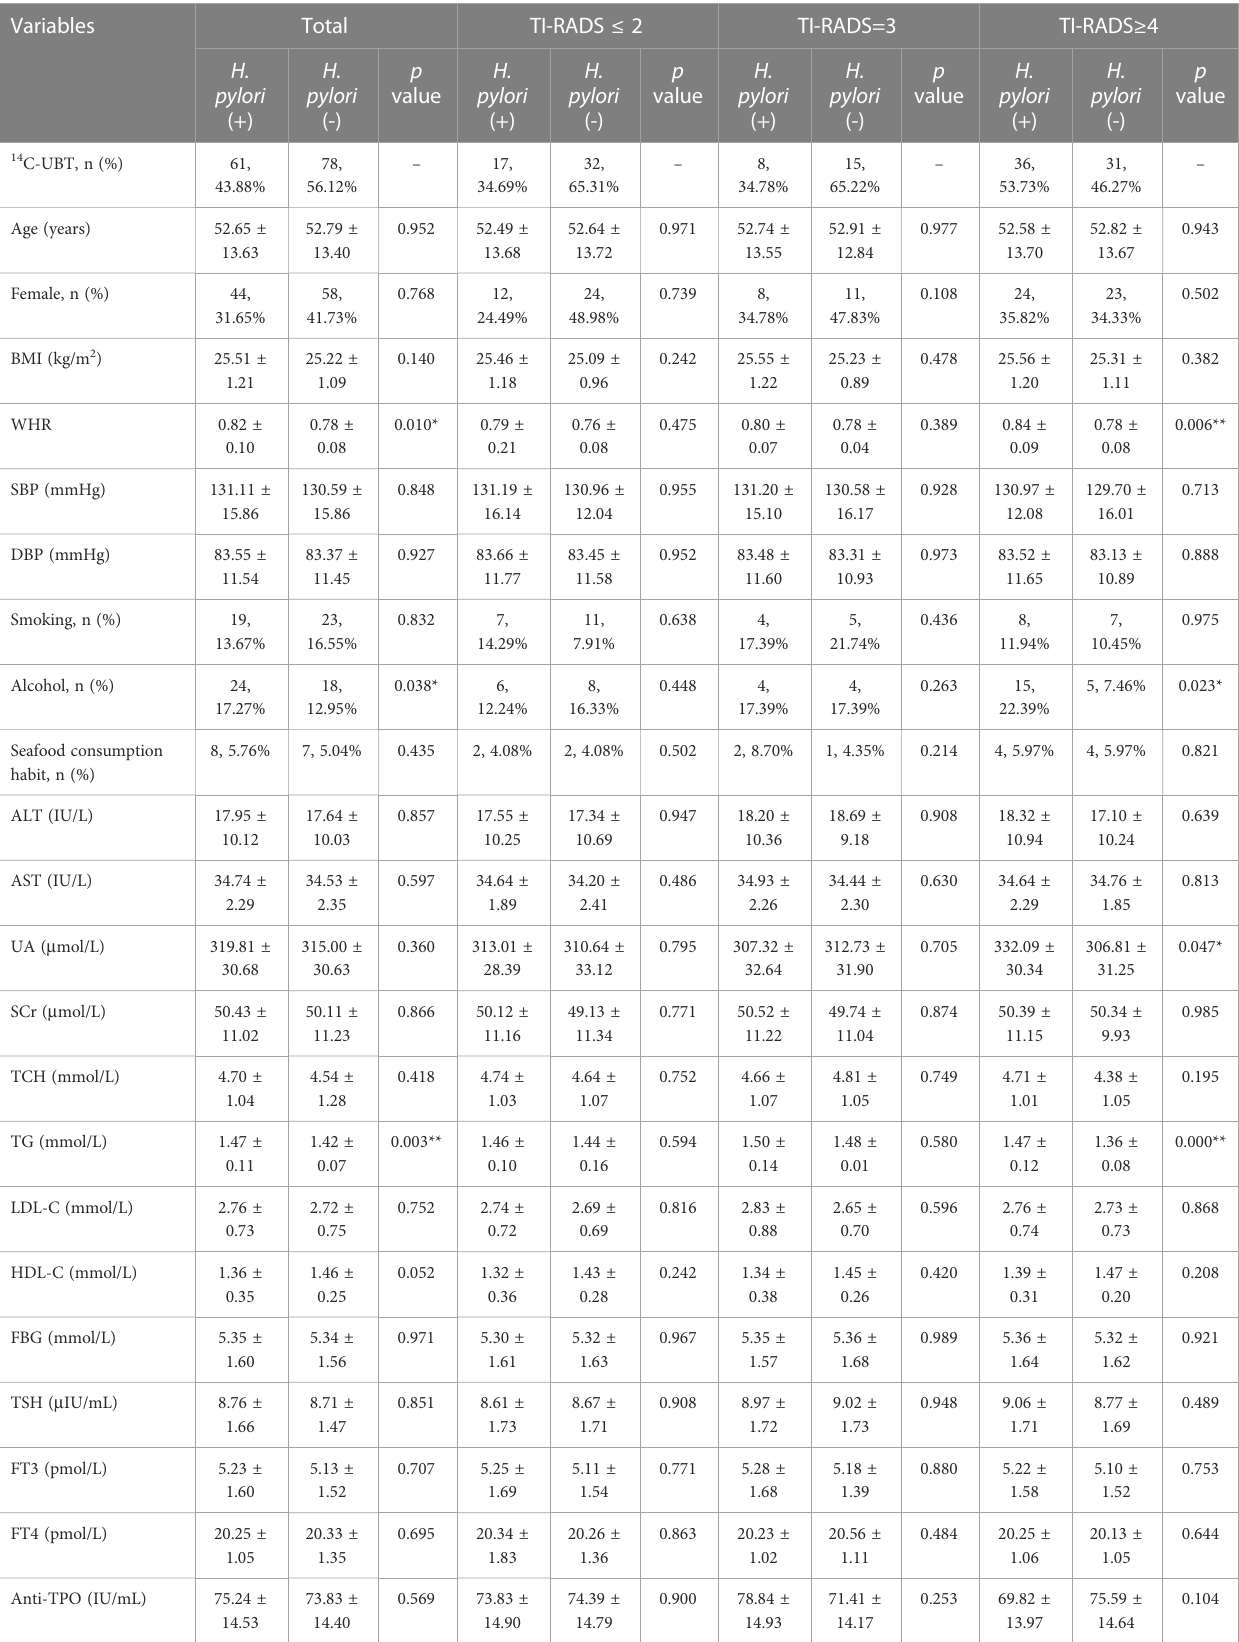
TABLE 4 The association between persistent H. pylori infection and risk of developing TN types in the 1 st year of 5-year follow-up.